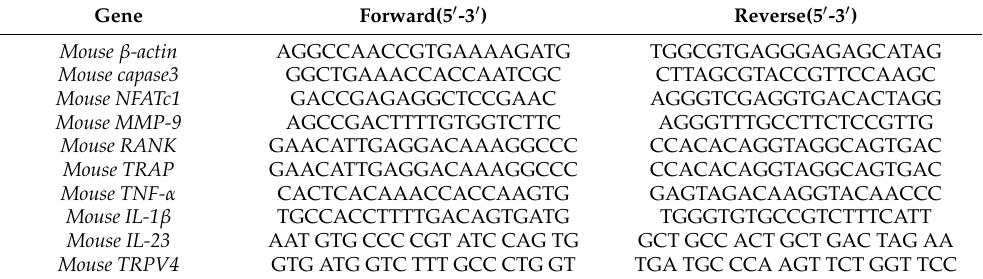
Table 1. PCR primer